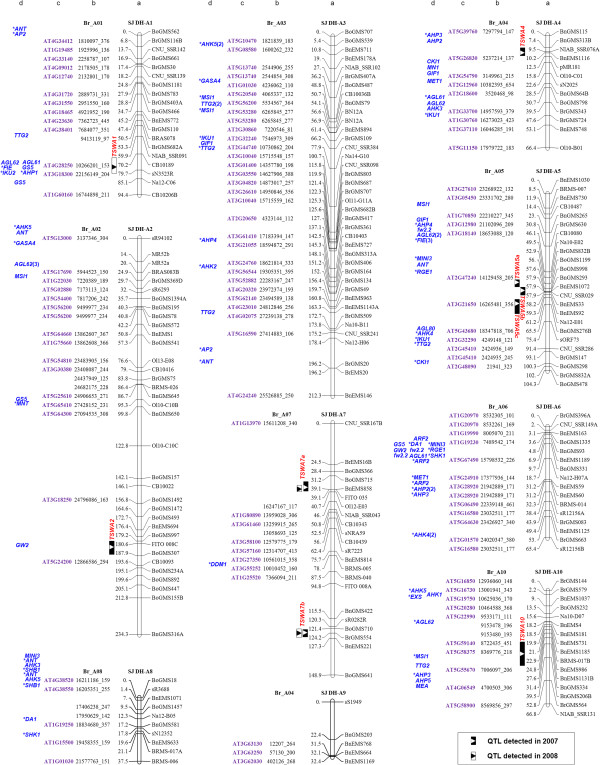
Seed weight/size gene distribution map of B. napus (A genome). Column a presents the genetic linkage groups of the SJ DH population. The nomenclature of LGs follows the rules proposed by the Multinational Brassica Genome Project [37]. Each of the LGs is represented with a vertical bar with the locus position (in cM) on the left and SSR loci names on the right. The QTLs information (peak, interval and name) of TSW were on the left-hand of the LGs. Column b lists the homologous colinear loci in B. rapa or B. oleracea. The numbers designate the physical position in B. rapa or B. oleracea chromosome with the length of amplification fragment. Column c is the Arabidopsis gene codes corresponding to the homologous loci. Column d lists the homologous genes of seed size or weight identified in B. rapa and B. oleracea. Genes that are in good fit into both Arabidopsis and B. rapa/B. oleracea physical positions are marked with asterisks. Numbers in brackets are the tandem repeat times of the tandem repeated genes.